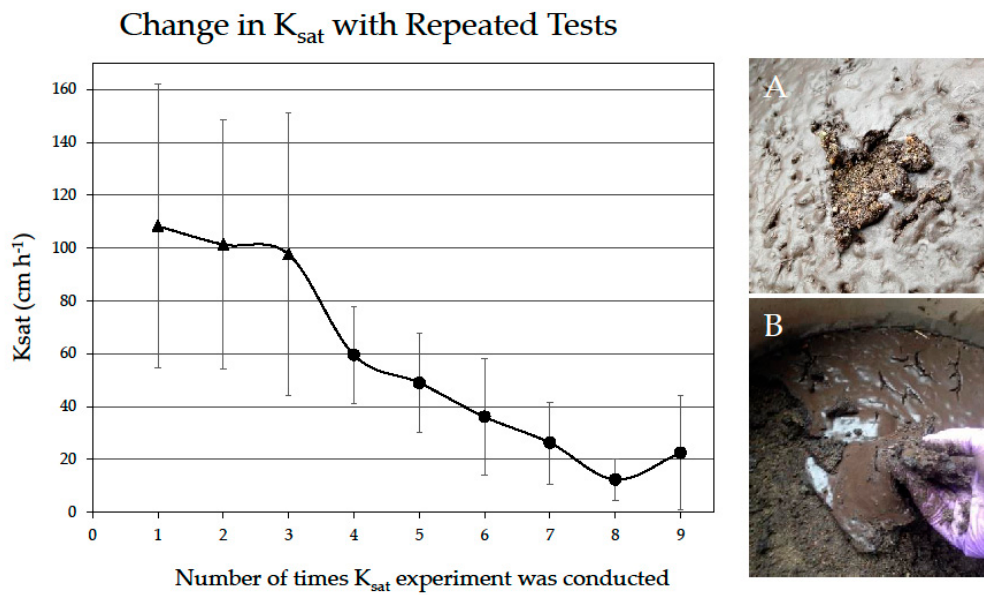
Figure 4. ( left ) Data represent the mean K sat value ± standard deviation for n = 12 bioretention cells (trials 1–3); n = 10–12 bioretention cells (trials 4–8); and n = 8 bioretention cells (trial 9). Triangles represent trials at bulk density = 1.25 ± 0.04 g cm − 3 , circles represent trials at bulk density = 1.41 ± 0.04 g cm − 3 . ( A ) A thin layer of fines rose through the bioretention soil with the rising water table during K sat testing. ( B ) The thickness of the layer of fines increased up to approximately 0.5 cm